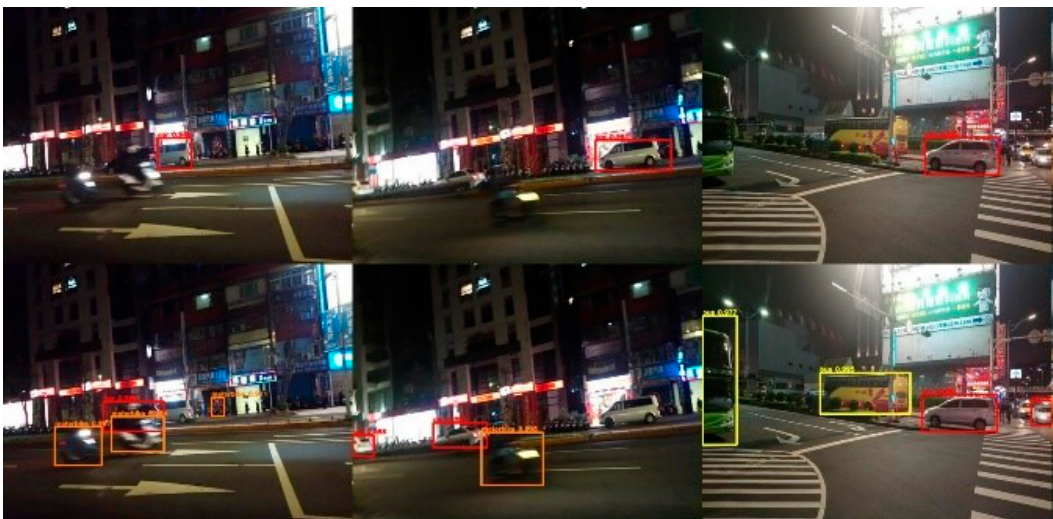
Figure 18. Output from two variants of the Faster R-CNN [5] with VGG16 [1]. Upper row: Ordinary model trained with PASCAL VOC 2007 [6]. Lower row: Proposed system trained with our nighttime data.